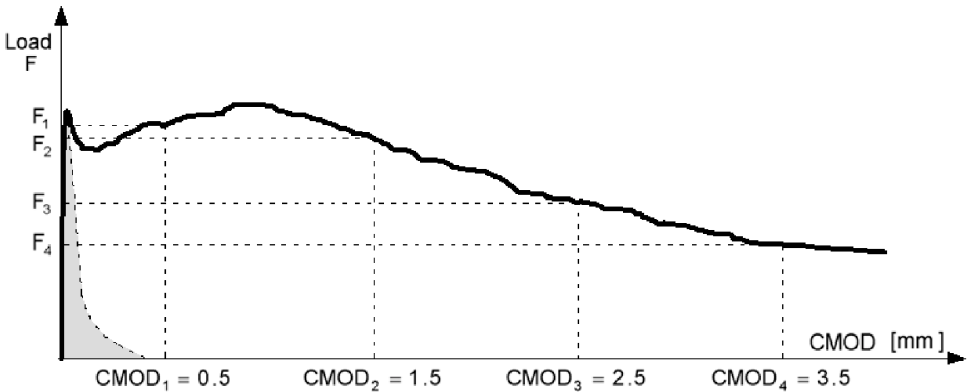
Figure 3. Applied load ( F ) versus crack mouth opening displacement ( CMOD ). Model Code 2010 [7].